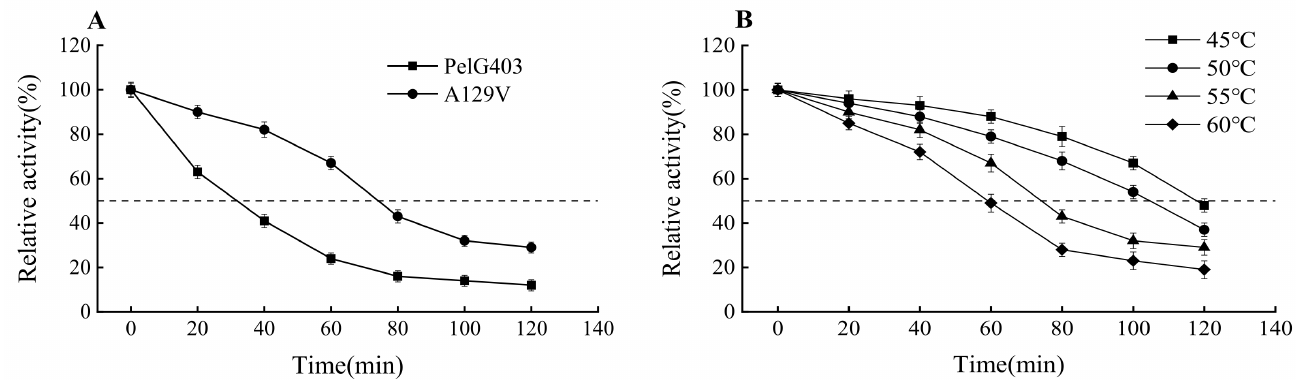
Figure 5. Thermal stability of wild-type PelG403 and A129V. ( A ) Comparison of half-life between wild-type PelG403 and A129V. After incubation at 55 ◦ C for 0–120 min, the wild-type PelG403 was measured at 50 ◦ C for enzyme activity, and A129V was measured at 55 ◦ C for enzyme activity. ( B ) Half-life of A129V mutant. After incubating at 45–65 ◦ C for 0–120 min, A129V was measured at 55 ◦ C for enzyme activity. The highest activity was taken as 100%. Values are the means ± SD of three